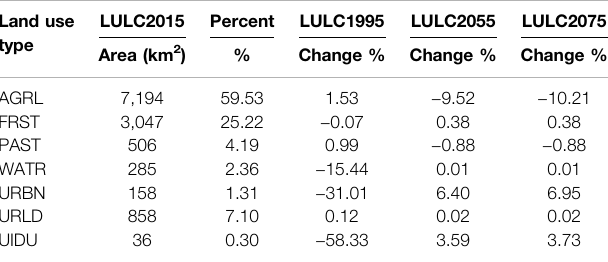
TABLE 3 | Land-use change during the past 20 years and the future 40